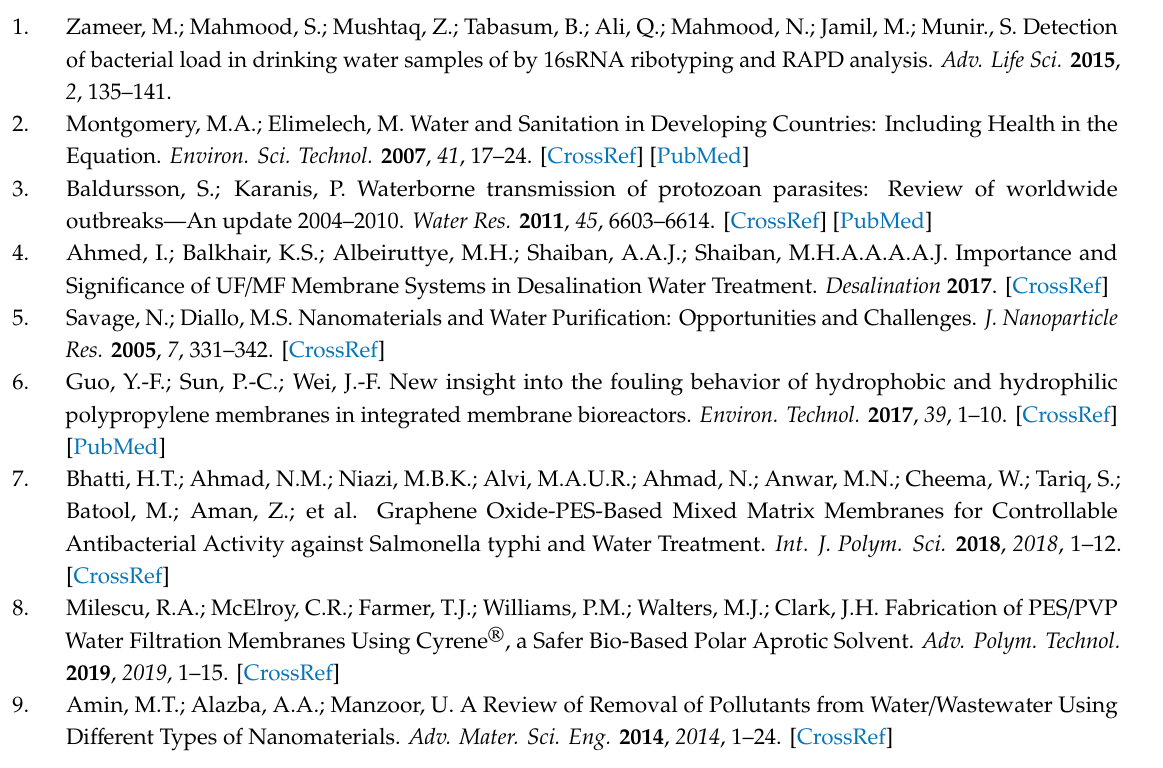
Figure S1(a,b): Antibacterial activity of Cannabinoids against Gram negative and Gram positive bacteria., Figure S1(b, c): Antibacterial activity of Terpenes against Gram negative and Gram positive bacteria, Figure S2: EDX analysis of (a) pure Polyethersulphone (PES) membrane, (b) Cannabinoid and Terpene embedded polyethersulphone (C + T-PES) membrane (c) Terpene embedded polyethersulphone (T-PES) membrane and (d) Cannabinoid embedded polyethersulphone (C-PES) membrane, Figure S3: Stress vs strain graph for (a)Pure polyethersulphone (PES) membrane, (b) Terpene embedded polyethersulphone (T-PES) membranes, (c) Cannabinoid embedded polyethersulphone (C-PES) membranes and (d) Cannabinoid and Terpene embedded polyethersulphone (C + T-PES) membranes, Figure S4: Contact angle analysis of (a)Pure polyethersulphone (PES) membrane, (b) Cannabinoid embedded polyethersulphone (C-PES) membranes,(c) Terpene embedded polyethersulphone (T-PES) membranes and (d) Cannabinoid and Terpene embedded polyethersulphone (C + T-PES)